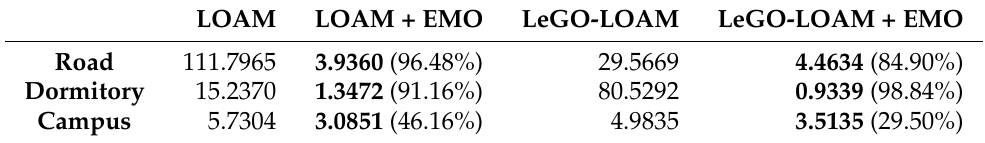
Table 2. The position RMSE (unit: m) of LOAM and LeGO-LOAM in three real-world dynamic tests with and without the moving objects elimination (EMO). The bold number indicate obvious improvement and smaller error. % indicates the percentage of error